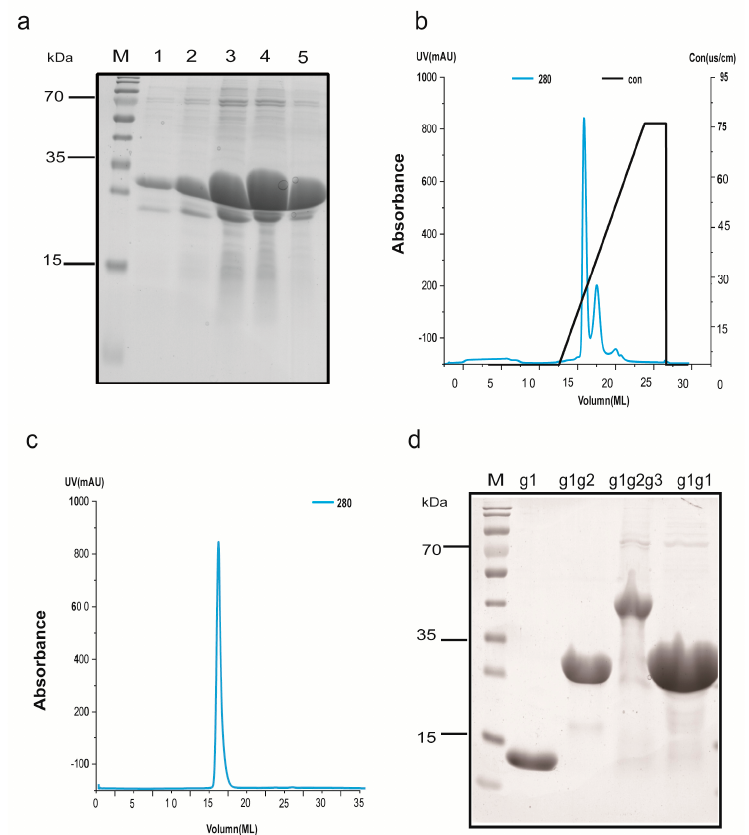
Figure 3. Purification procedures. ( a ) The sample is subjected to preliminary purification on a Ni-NTA column, and the purity was analyzed by 12% SDS-PAGE gels. M, molecular weight marker. Lanes 1–5, samples eluted sequentially at different times from the Ni-NTA column. ( b ) FPLC (1 mL HiTrap QHP) chromatogram showing effective separation. The blue line represents the UV absorption at 280 nM and the black line represents the change in the conductance. ( c ) Chromatogram of proteins purified with Superdex 200 increase 10/300GL. The blue line represents the UV absorption at 280 nM. ( d ) Analysis of the quality of the g1, g1g2, g1g2g3 and g1g1 proteins after purification on 12% SDS-PAGE